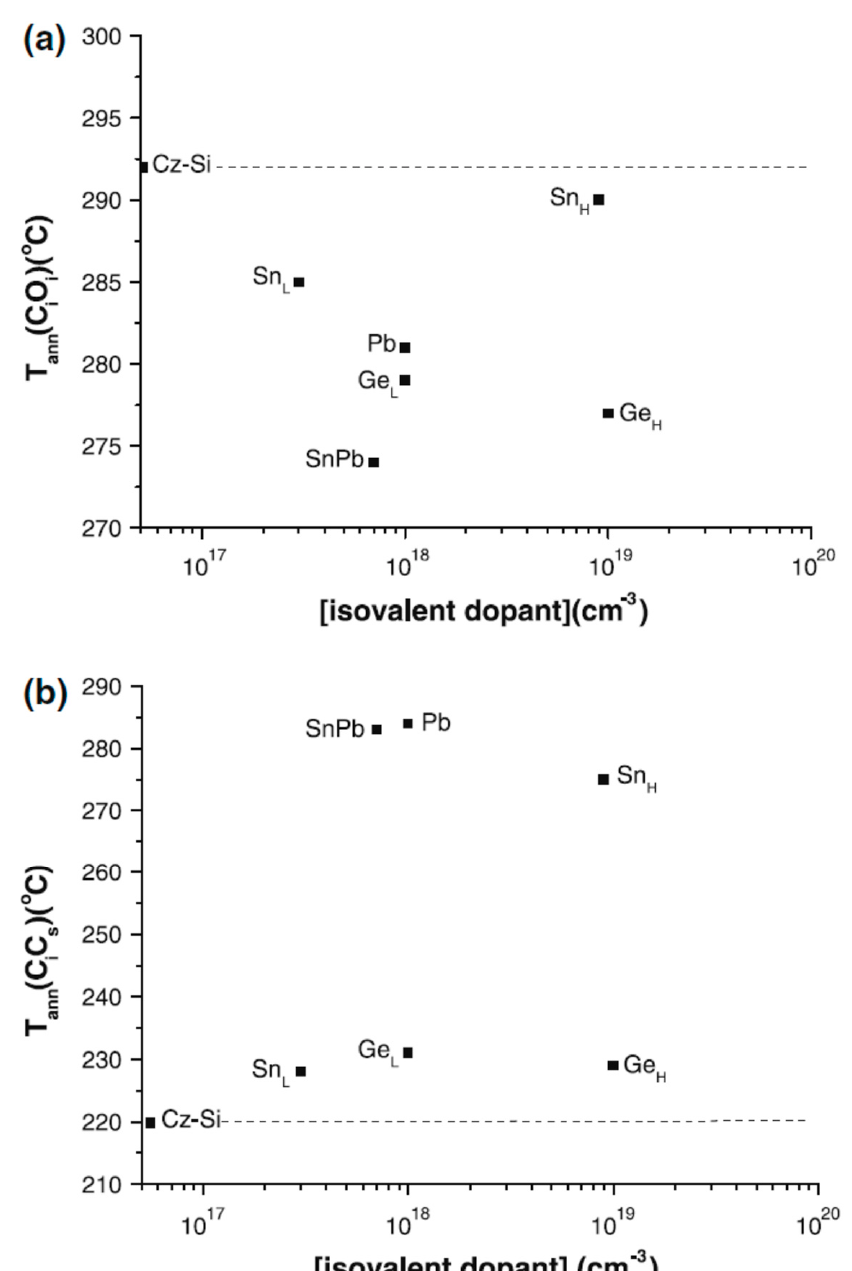
Figure 22. The annealing temperature T ann of C i O i ( a ), and C i C s ( b ), pairs versus the covalent radius of the isovalent dopants. Reproduced with permission from [158].